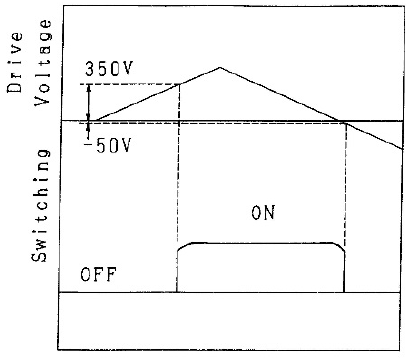
Figure 21. Tip displacement of the shape memory unimorph (y = 0.063) as a function of the external load. Figure 22. Basic ON/OFF function of the latching relay using the shape memory Figure 22. Basic ON/OFF function of the latching relay using the shape memory ceramic.